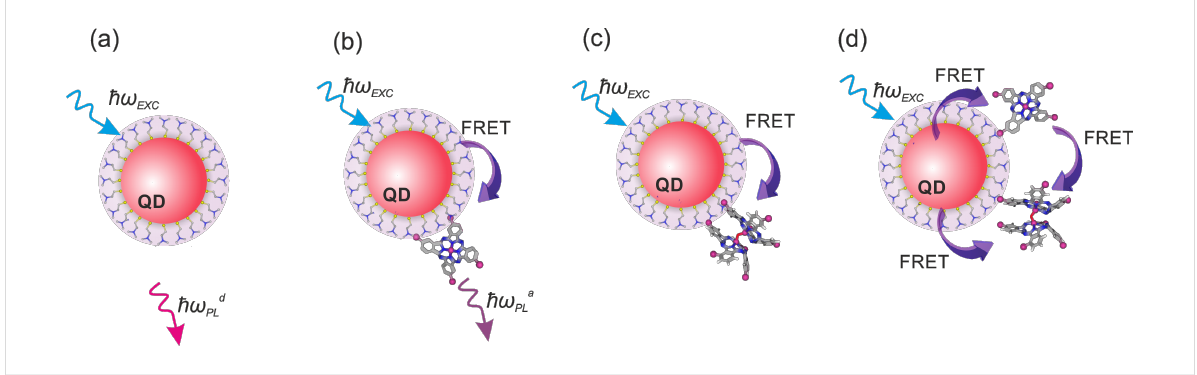
Figure 3: Heterogeneous system of QD–molecule complexes, which consists of free QDs (a), and complexes of QD with molecule monomers (b) and aggregates (c) as well as with both monomers and aggregates